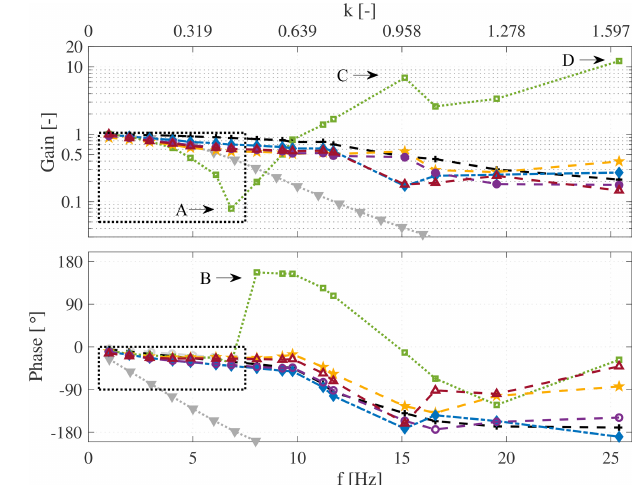
Figure 13. Bode plot of the transfer functions. Gray lines corre- spond to the filter setting and update time of the controller loop. Black line: transfer function from flap set point β SP to flap actual position β actual . All other lines correspond to β SP and to the lift measurements or lift estimates.